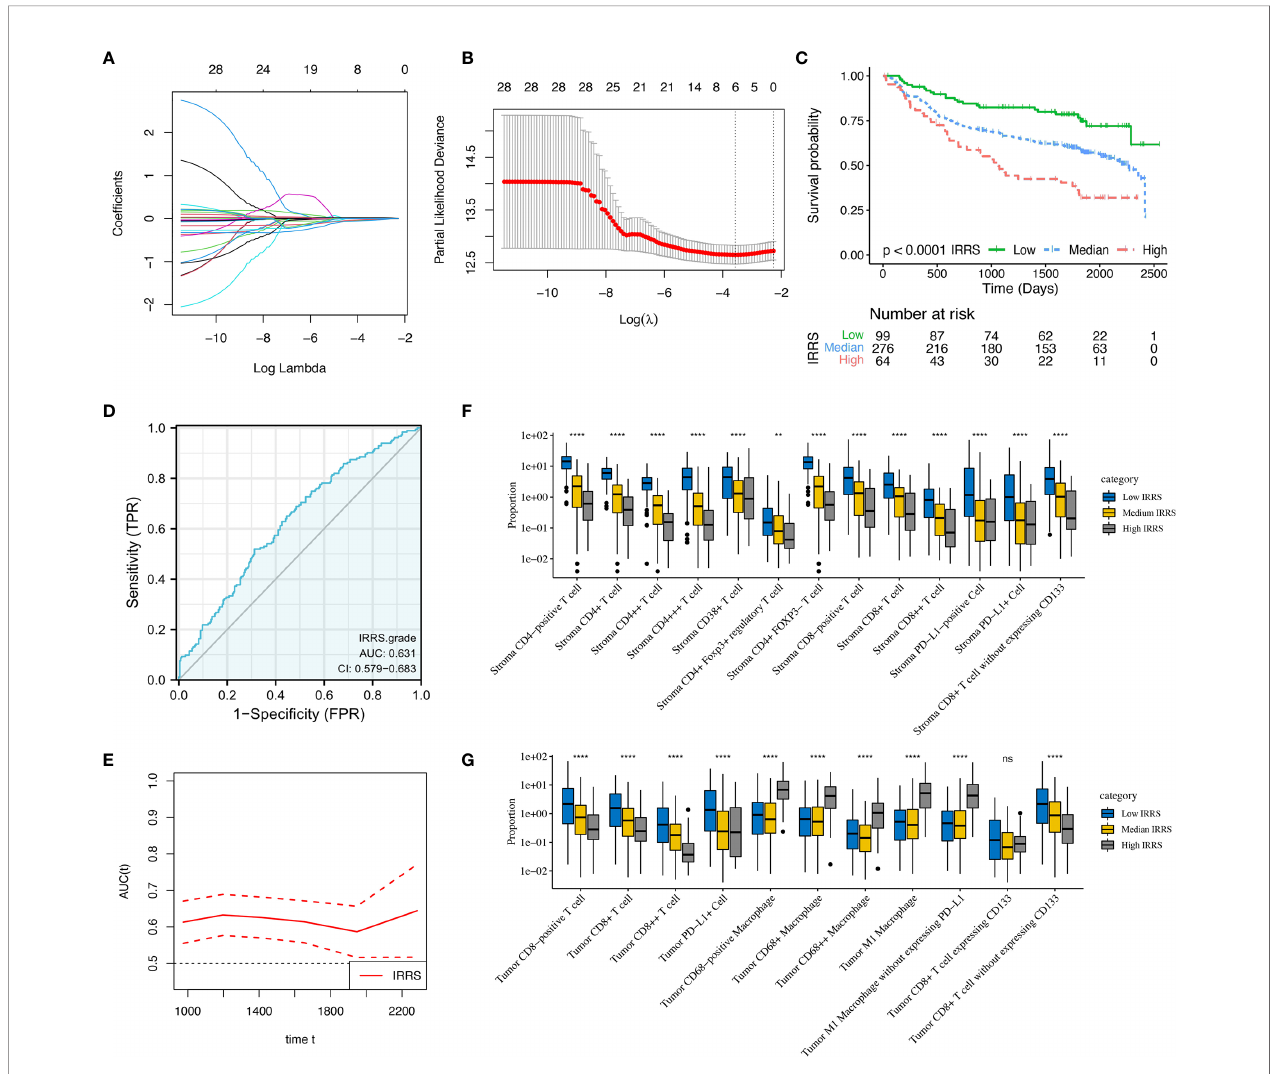
FIGURE 7 | Construction and validation of immune-related risk score (IRRS) in the training cohort. (A) Least absolute shrinkage and selection operator (LASSO) coef fi cient pro fi les of 28 selected immune cell biomarkers in the 10-fold cross-validation. (B) Partial likelihood deviance revealed by the LASSO regression model in the 10-fold cross- validation. (C) Kaplan – Meier curve estimates the differences of disease-free survival, divided by three IRRS subtypes (low vs. median vs. high). (D) Receiver operating characteristic curves and area under curve (AUC) values indicated the accuracy of the IRRS model. (E) Time-dependent AUC curve estimating the prognostic performance of IRRS. (F, G) Box plots present the in fi ltration disparities of three IRRS subgroups in tumor nest and tumor stroma. **P < 0.01; ****P < 0.0001; ns, nonsigni fi